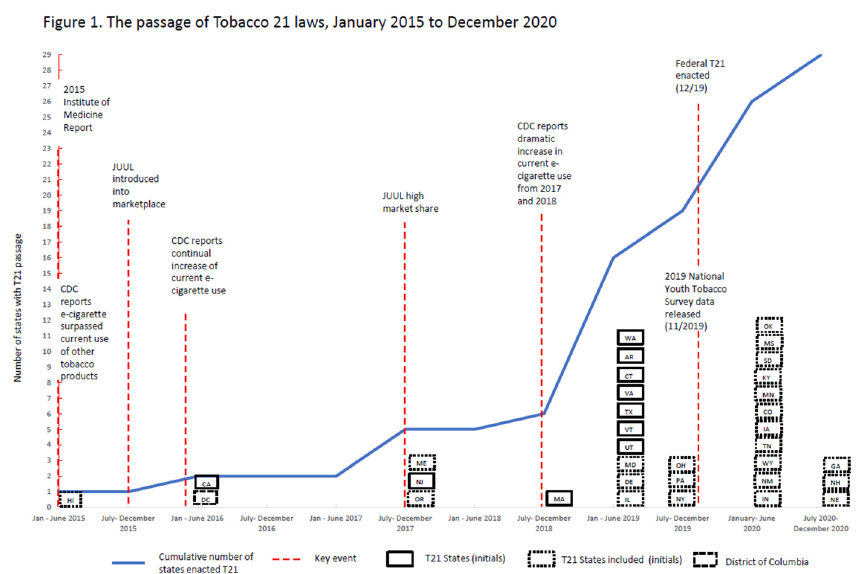
Figure 1. The passage of Tobacco 21 laws, January 2015 to December 2020.